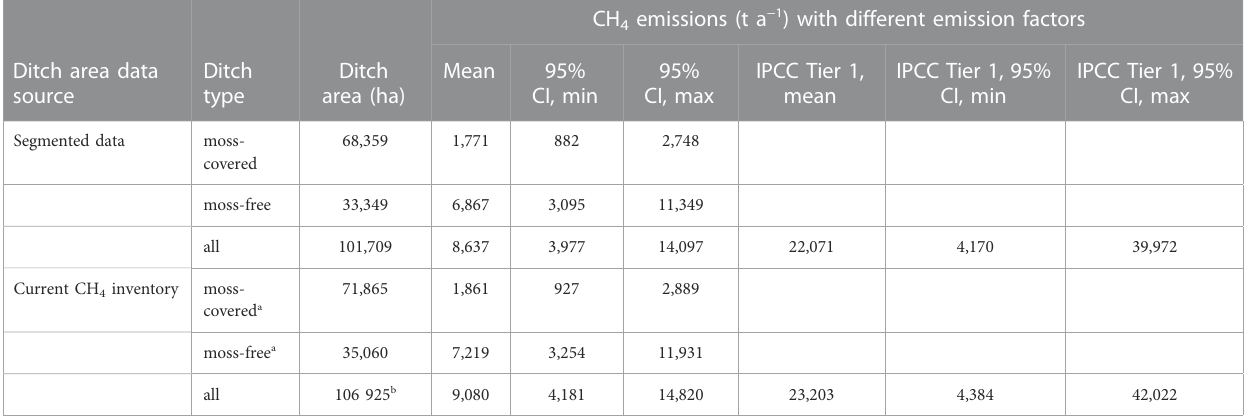
TABLE 5 Ditch areas and CH 4 emissions for moss-covered and moss-free ditches in Finland. The shares of moss-covered and moss-free ditch areas (Table 4) are based on the results from models RF25 and RF42 (see Datasets 5 and 6). For emission factors (mean and 95% con fi dence interval (CI)), see Table